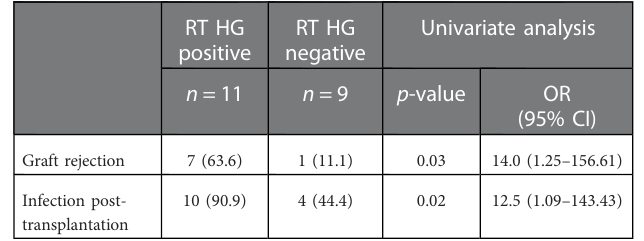
TABLE 7 Univariate analysis for RT cohort (rDIABGRAFT).